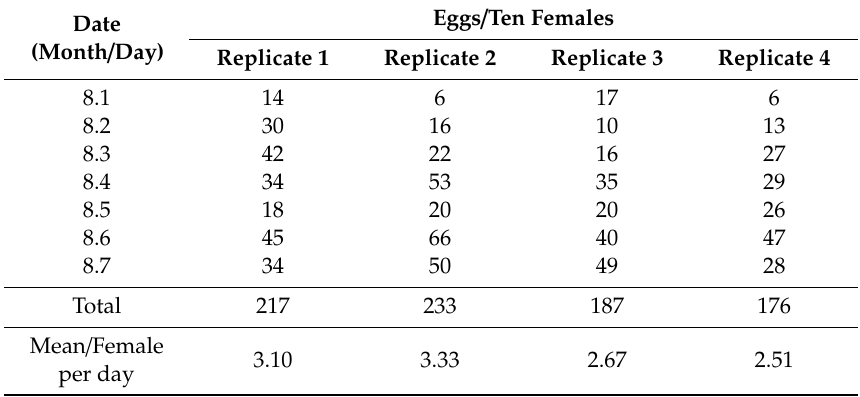
Table 6. Egg laid by a single female of E. onukii on a single day.